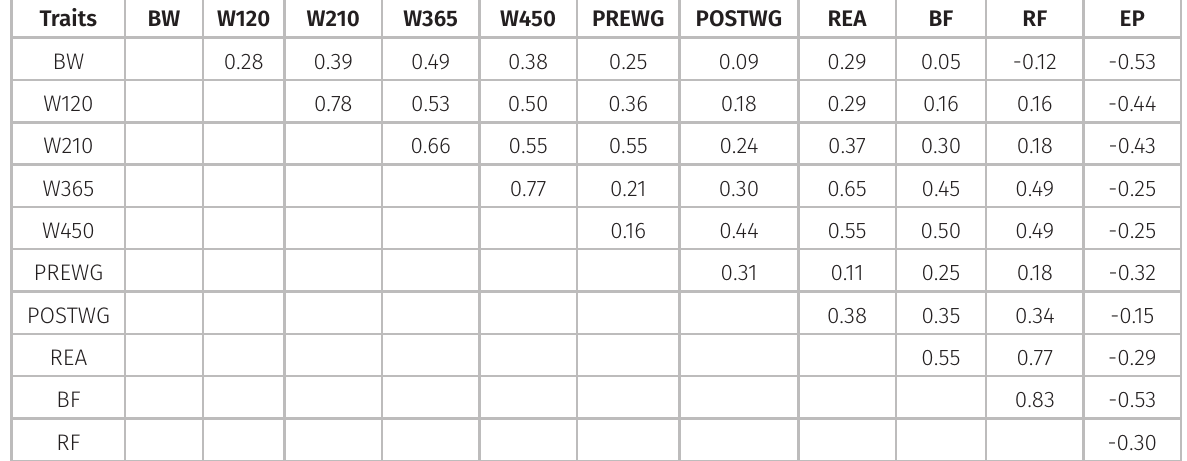
Table VI. Pearson correlations between growth and carcass traits with early pregnancy heifer.